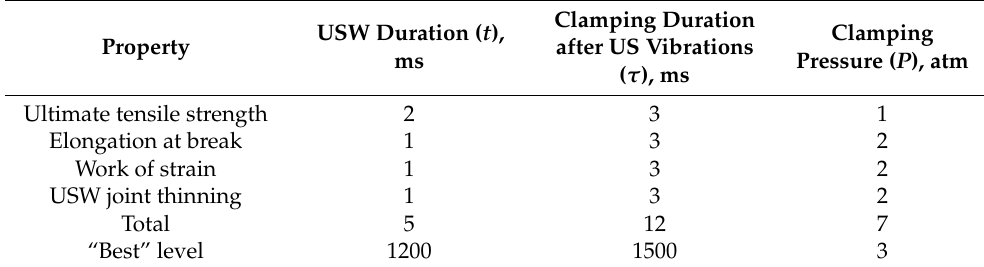
Table 3. Influence of the USW parameters on the joint characteristics.